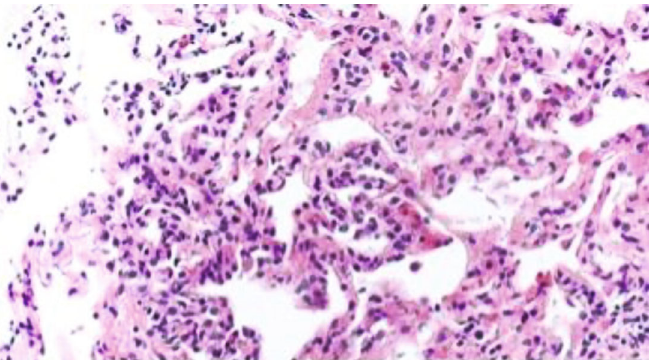
Figure 4: Photomicrograph of transbronchial biopsy showing mild lymphocytic alveolar in fi ltrates (hematoxylin and eosin